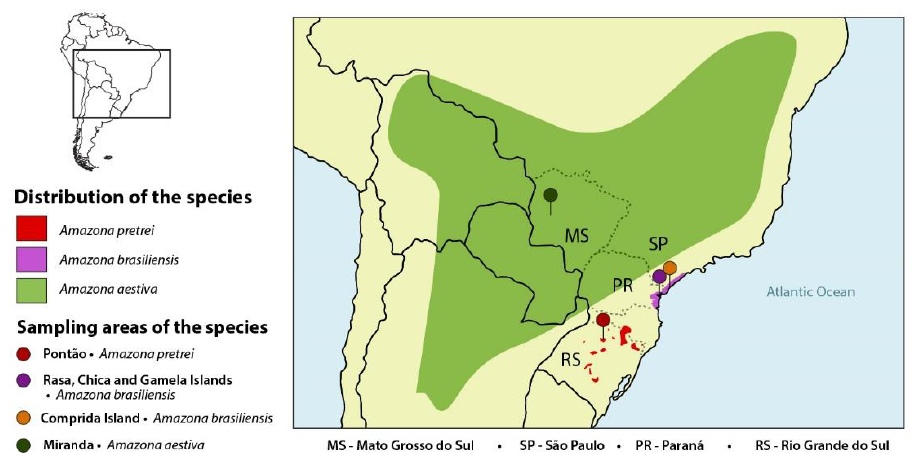
Figure 1. Distribution of Amazona pretrei, Amazona brasiliensis and Amazona aestiva in Brazil and South America and sampling areas.